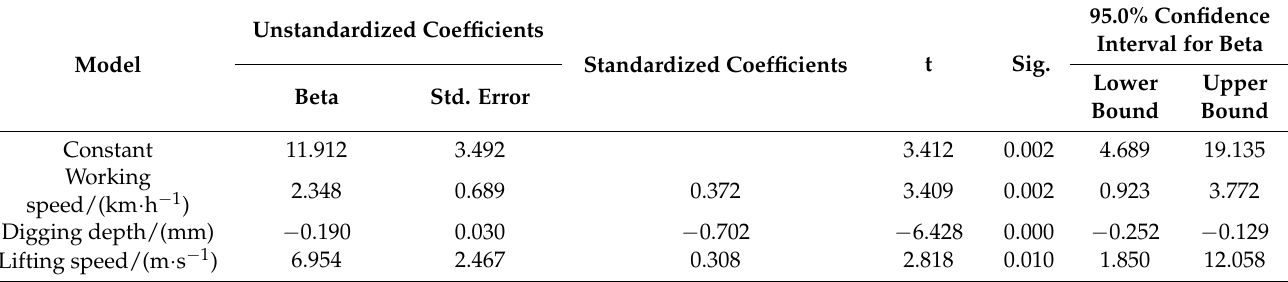
Table 6. Analysis on regression